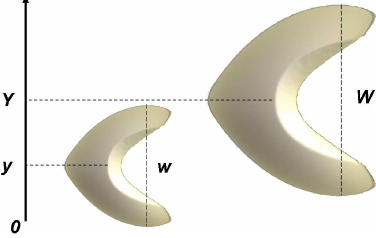
Fig. 5. (Color online) Sketch of the initial state of a binary collision between two barchan dunes of sizes w and W , and centered at y and Y , respectively.